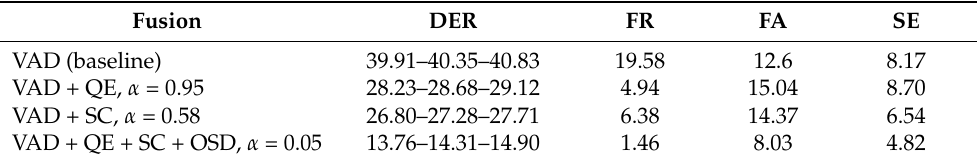
Table 6. Results for the AMI evaluation set in terms of DER decomposed to false rejection errors, false acceptance errors and speaker errors for the fusion of different model